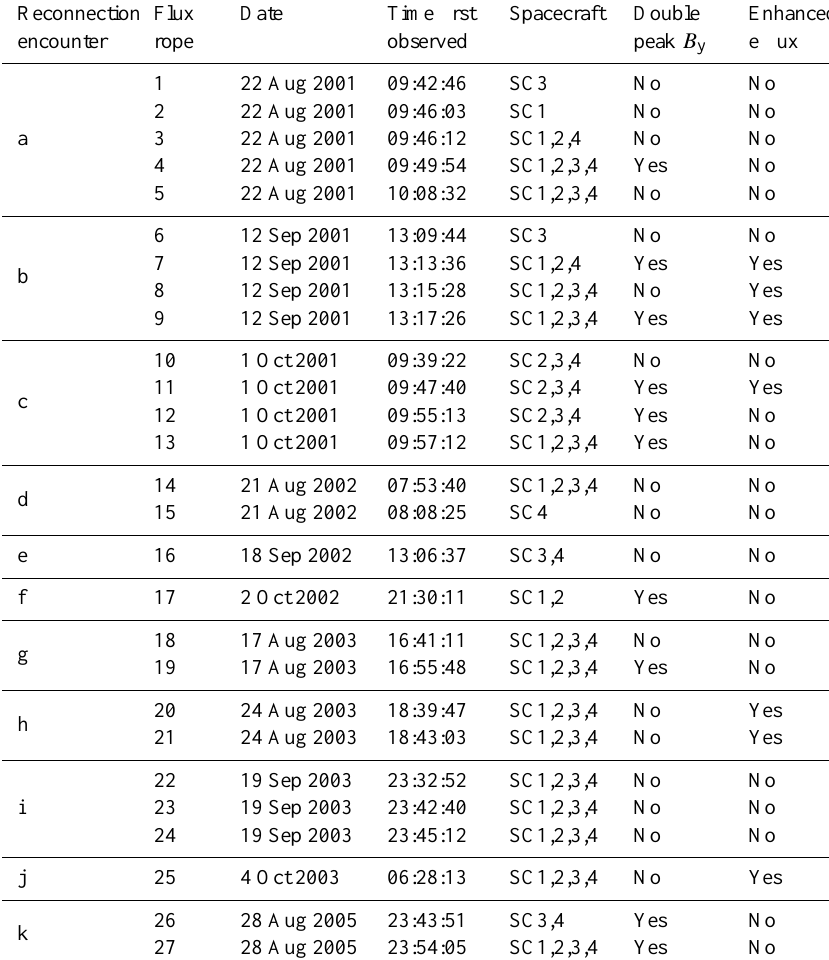
Time first observed